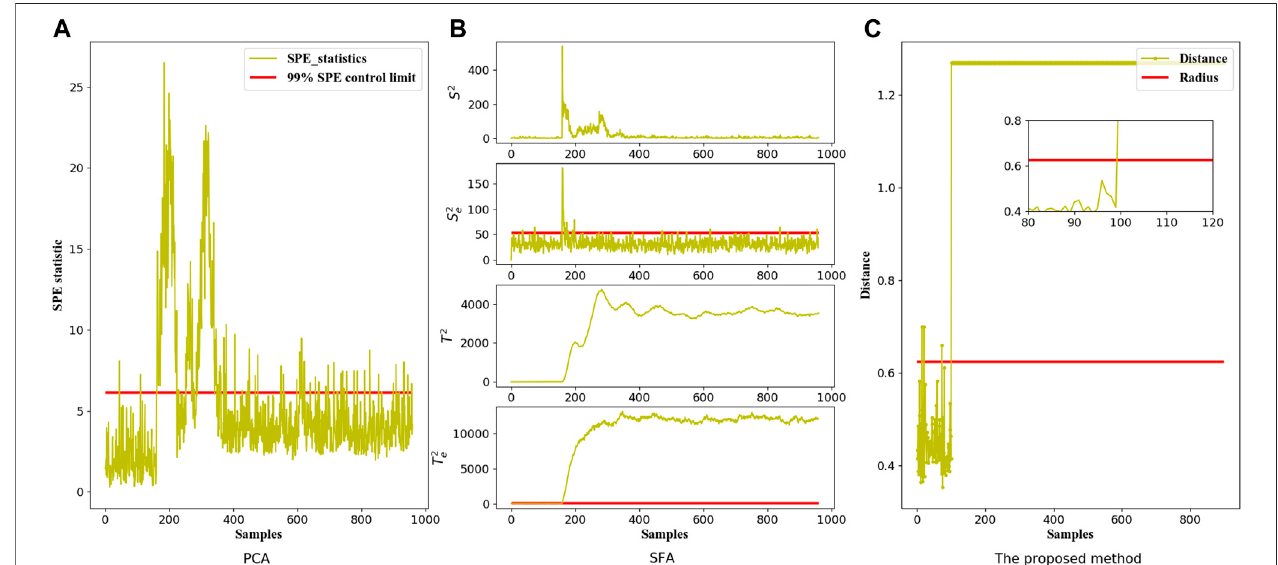
FIGURE 4 | The Fault monitoring graphs of Fault 5 in the TEP dataset corresponding to three different models: (A) PCA model, (B) SFA model and (C) The proposed multi-scale model.